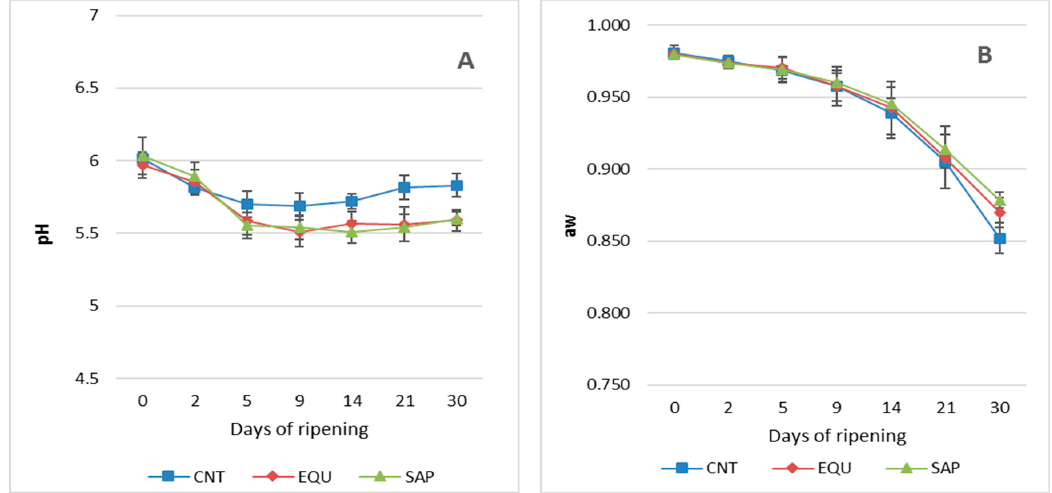
Figure 1. Evolution of the pH ( A ) and a w ( B ) values along the manufacturing process of Galician sausage made without and with additives (plotted values are means ± standard deviations of three replicates in each sausage group). CNT: Non-inoculated control batches; EQU: Batches inoculated with L. sakei + S. equorum ; SAP: Batches inoculated with L. sakei + S. saprophyticus .